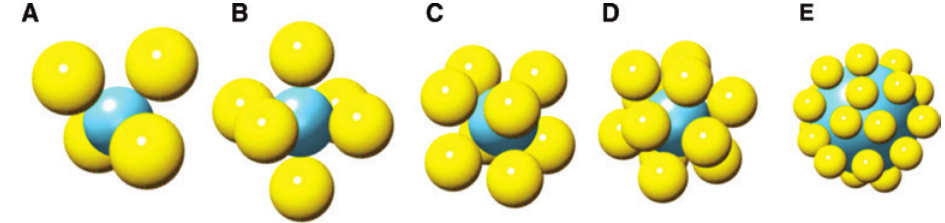
Figure 1: Illustrations of five multipode morphologies. Sketch of the tetrapod (A), hexapod (B), octapod (C), and dodecapod (D) models used in numerical simulations with the same amount of gold distributed in N satellites around the same dielectric core (the radius of the satellites scales as N −1/3 ) and (E) the “plasmonic raspberry” model [8, 18].